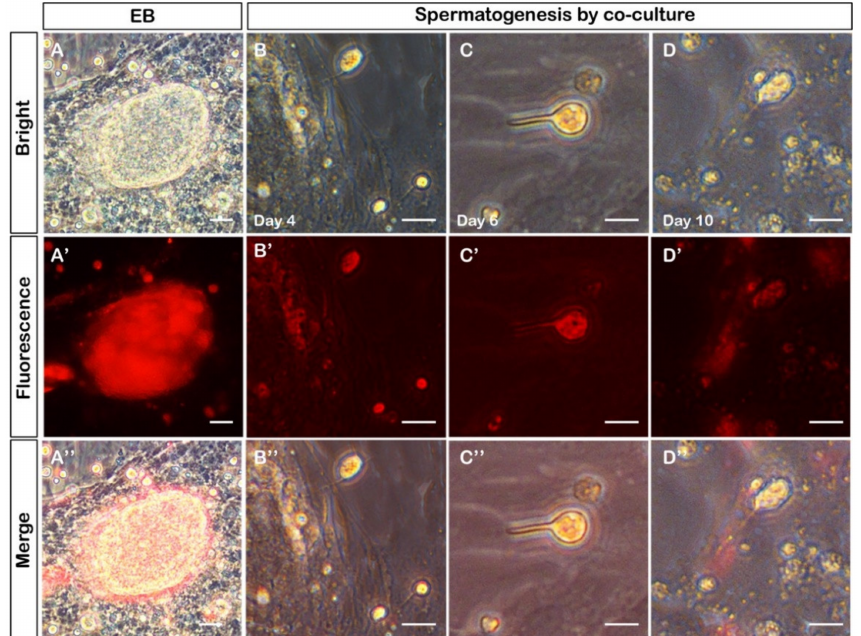
Figure 5. Sperm production in vitro . ( A ) Embryoid bodies were produced by co-culture of CnGSC cells and RFP-labelled SG3 cells. The large spherical structure is wrapped with SG3 cells and sur- rounded by somatic cells with a clear boundary. ( B , C ) SG3 cells differentiated into round spermatids with flagellum in vitro 4 days later. ( D ) The tail of sperm cells elongated 10 days later. (Bars = 100 µ m in ( A – A” ); Bars = 10 µ m in ( B – D” )).